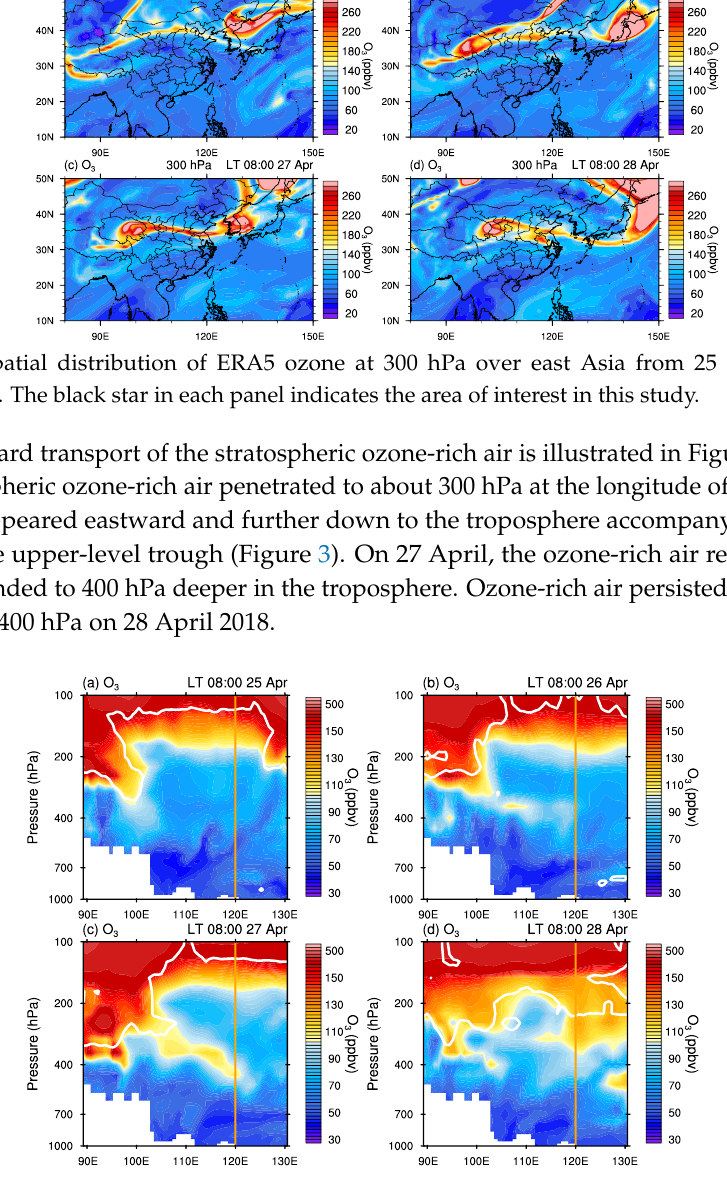
Figure 8. Longitude-height cross sections of ERA5 ozone at 30 ◦ N from 25 April 2018 to 28 April 2018. ( a ) 25 April, ( b ) 26 April, ( c ) 27 April and ( d ) 28 April 2018. The white line indicates the dynamical tropopause (2 PVU). The vertical line indicates the longitude (120 ◦ E) of